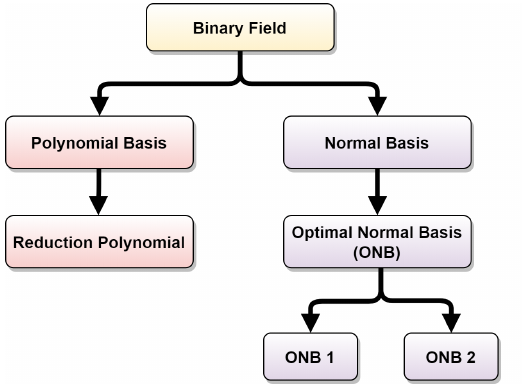
Figure 2. Binary Field.